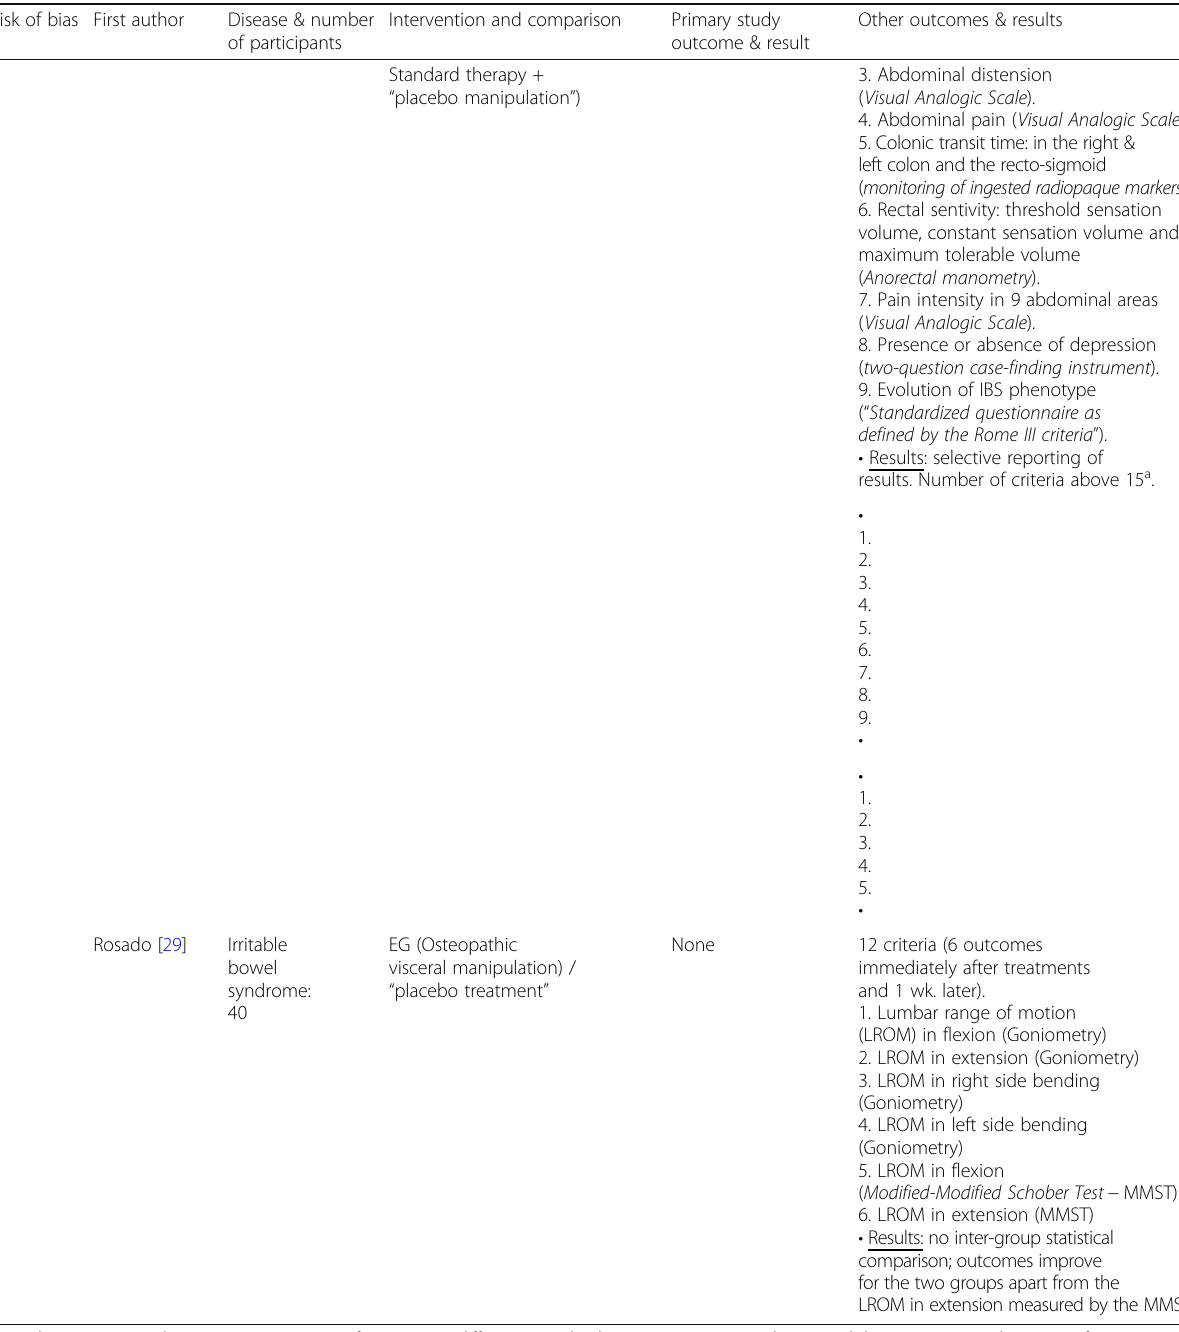
Table 2 Description of included studies dealing with the clinical efficacy of techniques used in visceral osteopathy (Continued) Risk of bias First